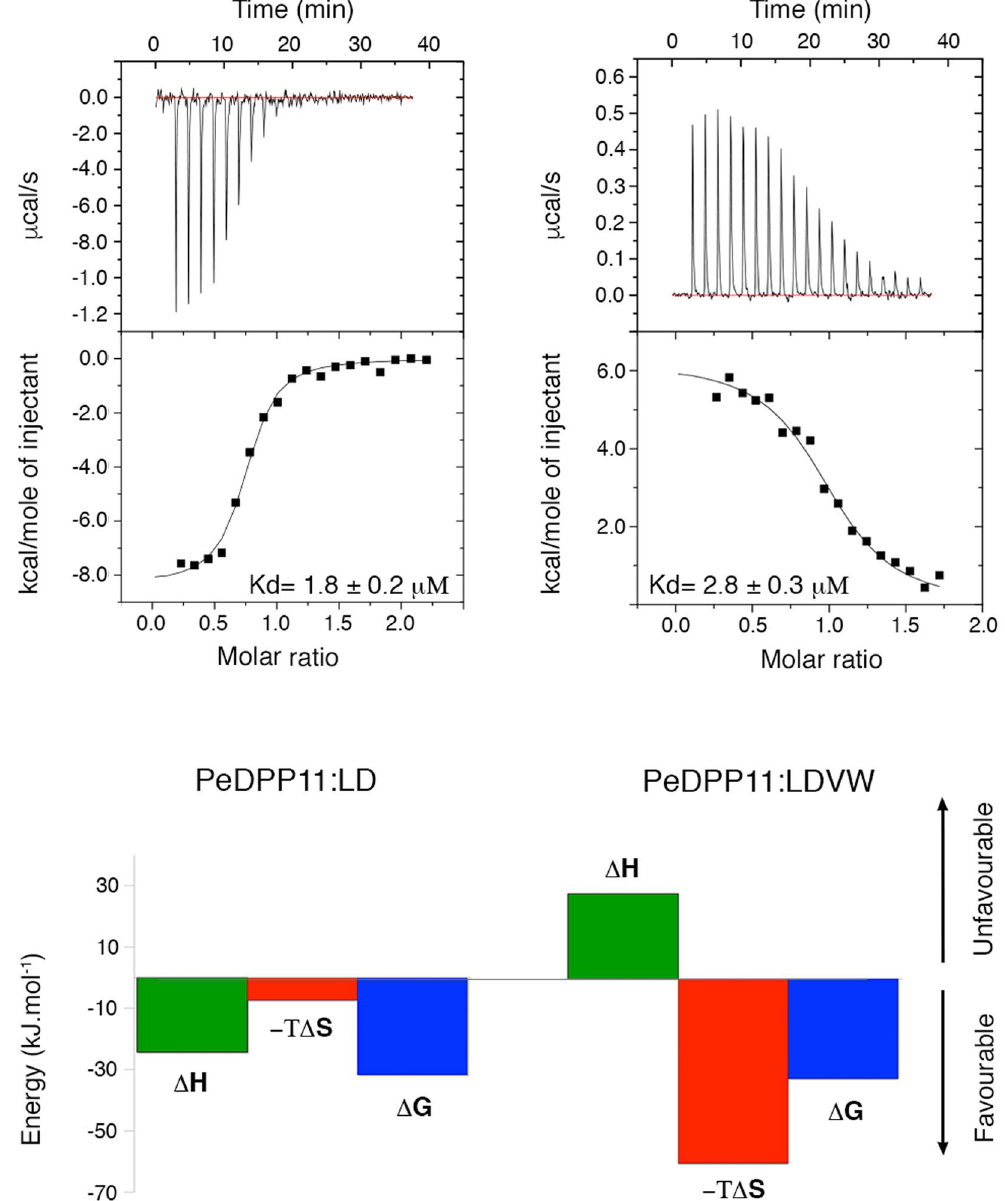
Figure 2. Microcalorimetric analysis. Isothermal titration calorimetry experiments performed by titrating LD (left panel) and LDVW (right panel) into PeDPP11. Upper panel shows time-dependent deflection of heat for each injection (top). Integrated calorimetric data for the respective interactions (bottom). The continuous curve represents the best fit using a one-site binding model. Lower panel shows the graphical representation of thermodynamics